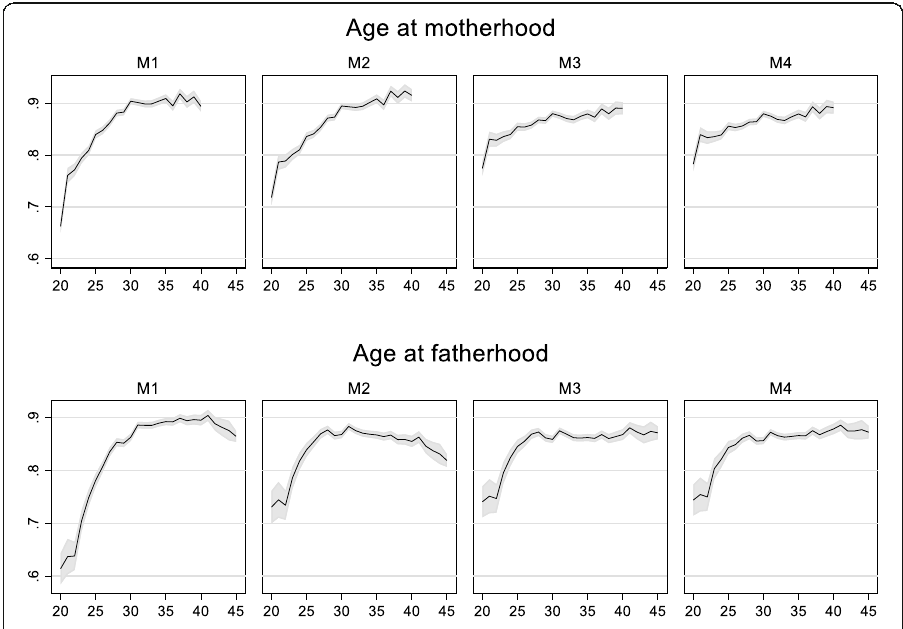
Fig. 1 Mother ’ s and father ’ s age at childbirth and probabilities of being enrolled in a 5-year